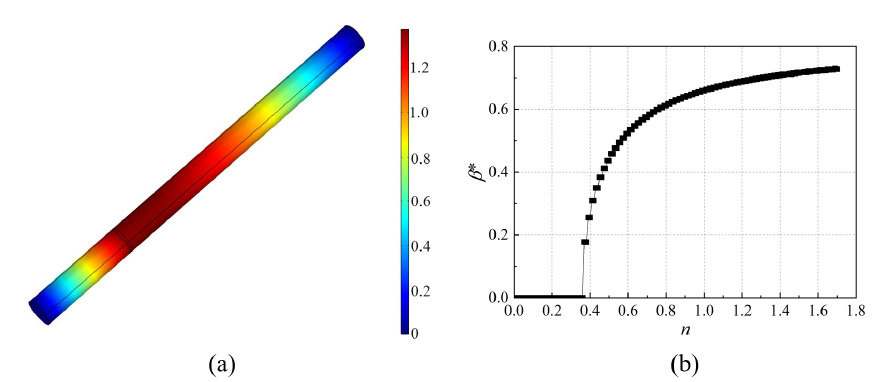
Figure 6. ( a ) First order longitudinal mode of pressure perturbation in the Rijke tube; ( b ) Bifurcation diagram of the Rijke tube describing oscillation condition ( β ∗ ) for different index n of the flame describing